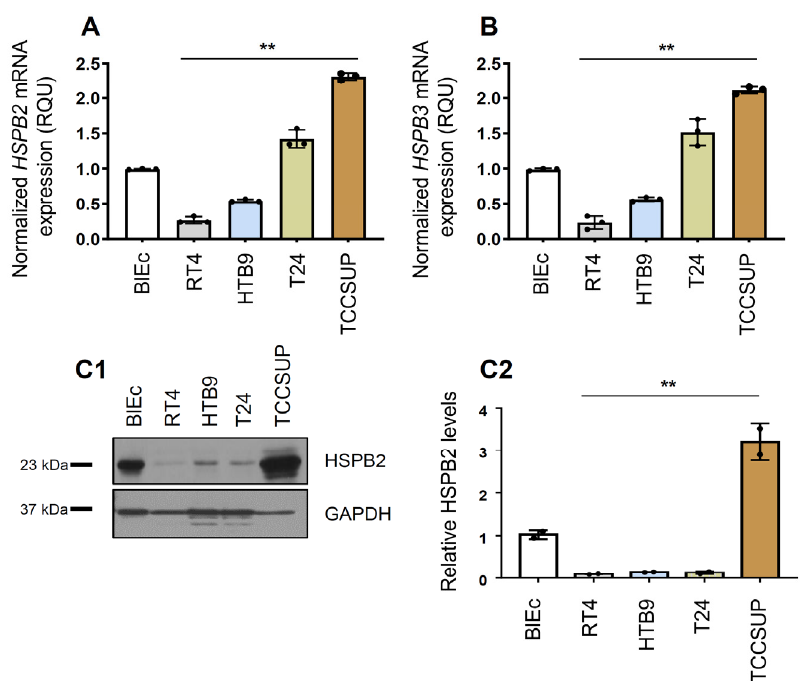
Figure 1. ( A , B ) Relative HSPB2 and HSPB3 mRNA expression levels in BlCa cell lines of increasing malignancy vs. BlEc cells; genes’ expression in BlEc cells was set to 1. ( C1 ) Representative immunoblotting analysis of HSPB2 in BlCa cell lines vs. B1Ec cells. Probing with GAPDH was used as total protein loading reference. ( C2 ) Relative protein quantification of HSPB2 in BlCa cell lines vs. B1Ec cells; proteins’ expression in BlEc cells was set to 1. p -value was calculated using unpaired t -test. Bars, ±SD; ** p < 0.01.